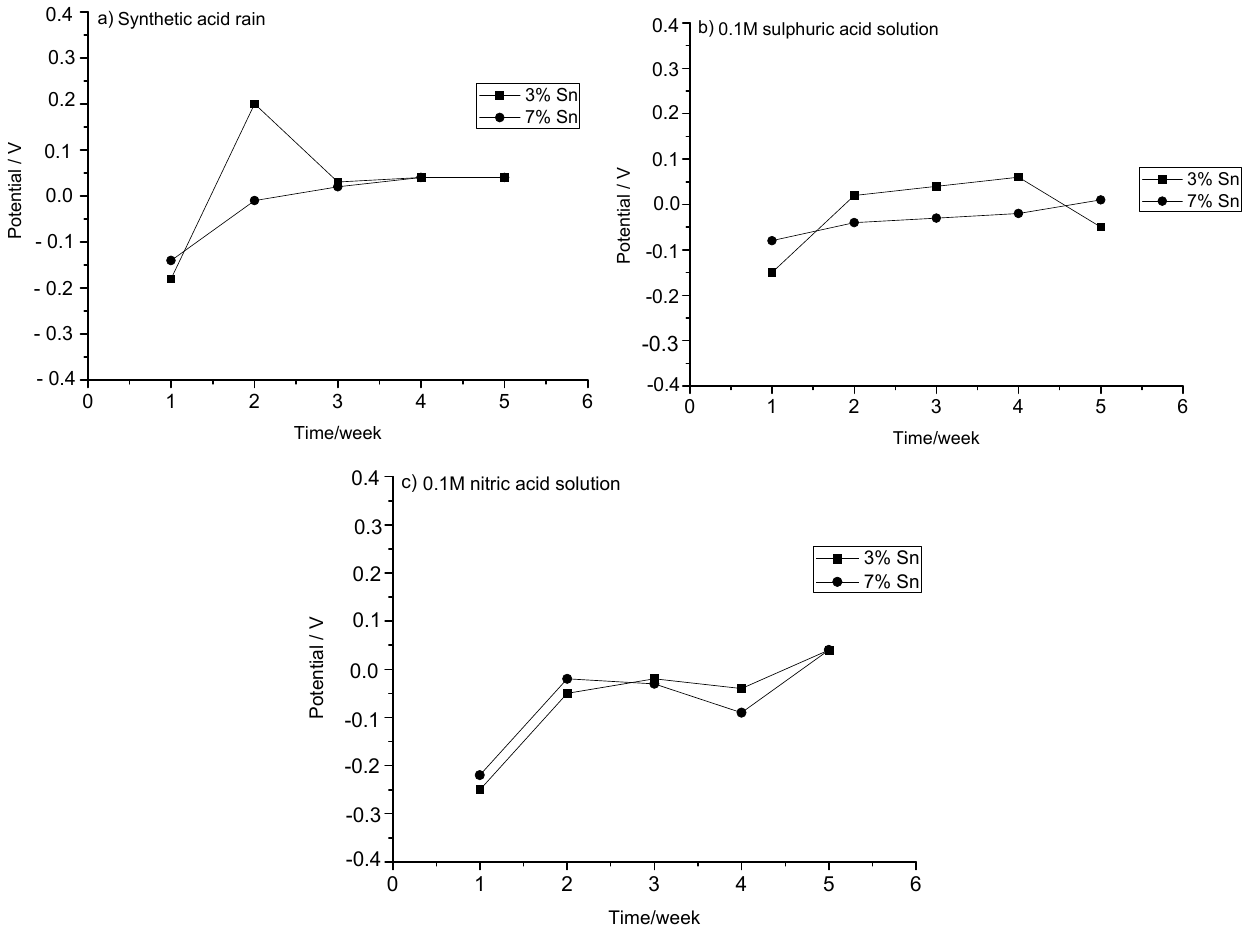
Figure 1. OCP measurements during five weeks of immersion of 3% Sn and 7% Sn bronzes in ( a ) synthetic acid rain solution; ( b ) 0.1 M sulphuric acid; and ( c ) 0.1 M nitric